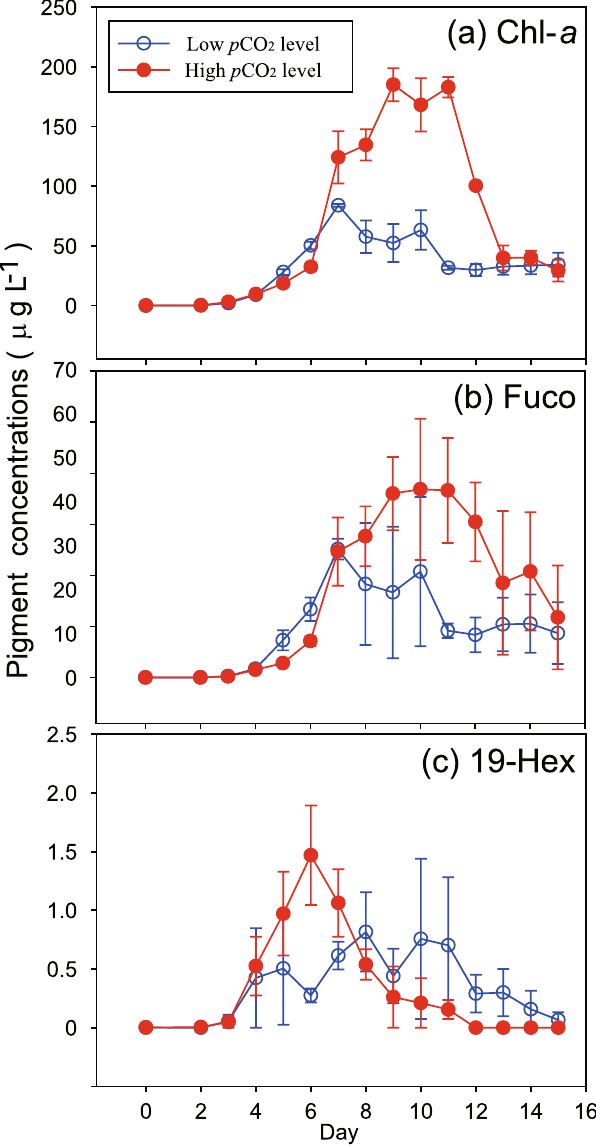
Figure 6. Temporal variations in concentrations of chlorophyll a ( a ) and diagnostic pigments of diatoms ( b , Fucoxanthin) and prymnesiophytes ( c , 19 ′ hexanoyl-oxy-fucoxanthin, 19-Hex) in 6 seawater enclosures which were perturbed by bubbling with ambient air (400 ppmv CO 2 , Low CO 2 level) or an air/CO 2 mixture at a concentration of 1000 ppmv CO 2 (High CO 2 level). Symbols are the means and error bars are the standard errors of three replicate